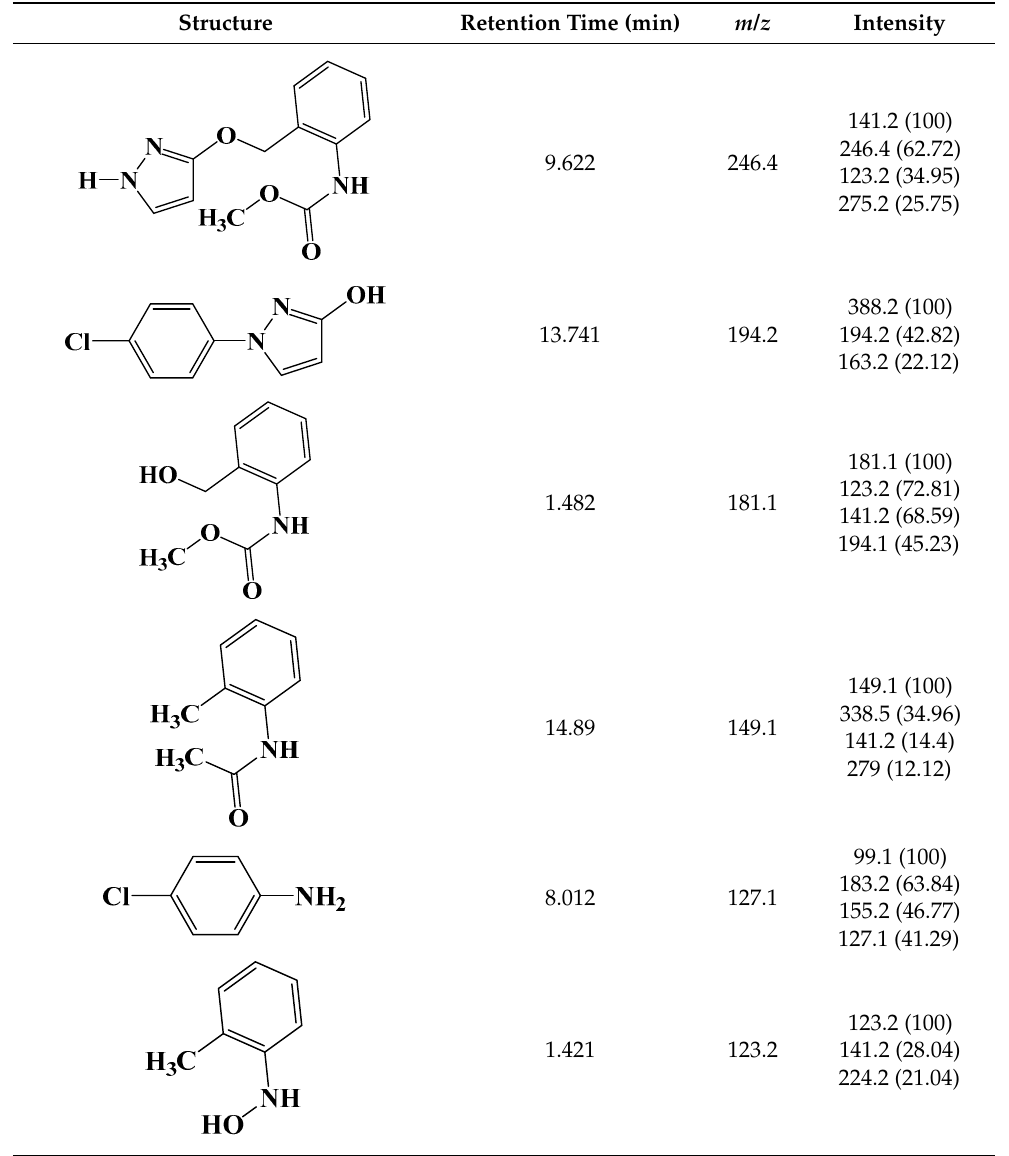
Figure 7. The chromatogram before and after plasma treatment was obtained by